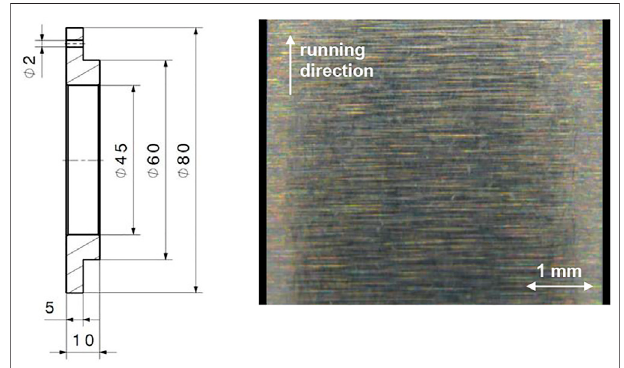
FIGURE3| Testdiskgeometry (left) and lightmicroscopepicture ofthe running surface before test run (right).